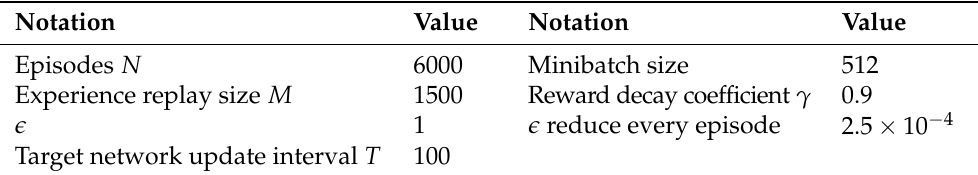
Table 3. Parameter setting of RL training process.